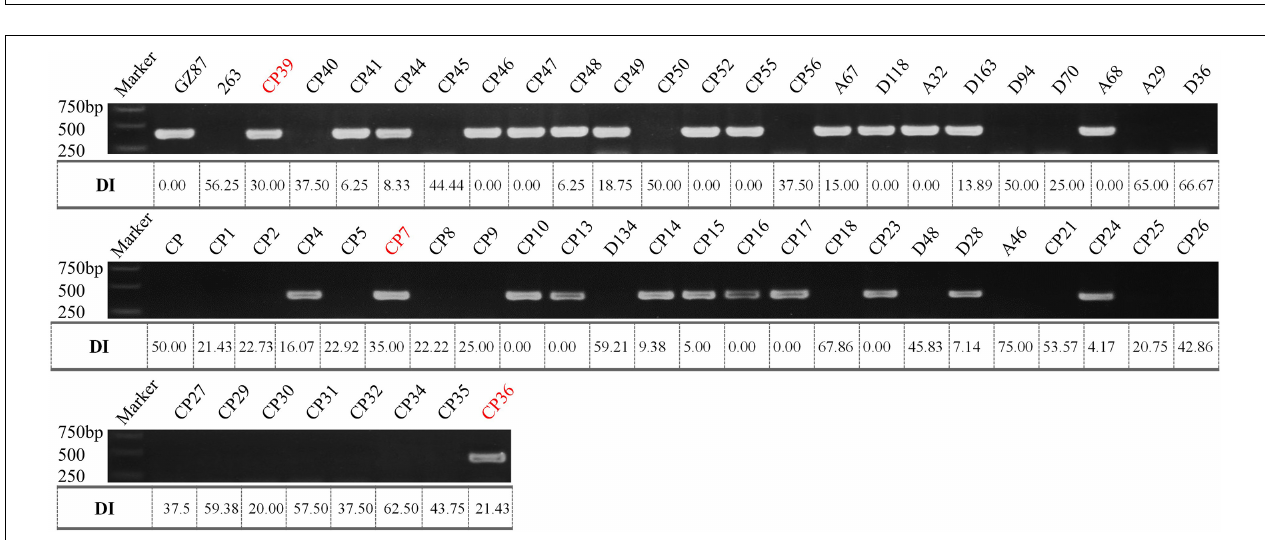
FIGURE 4 | Comparison of expression patterns of nine DEGs located within C07 QTL regions in R and S pools before and after inoculation. The relative expression in qRT-PCR was indicated by bars with ordinate on the left; the FPKM in RNA-seq was presented by lines with ordinate on the right side.